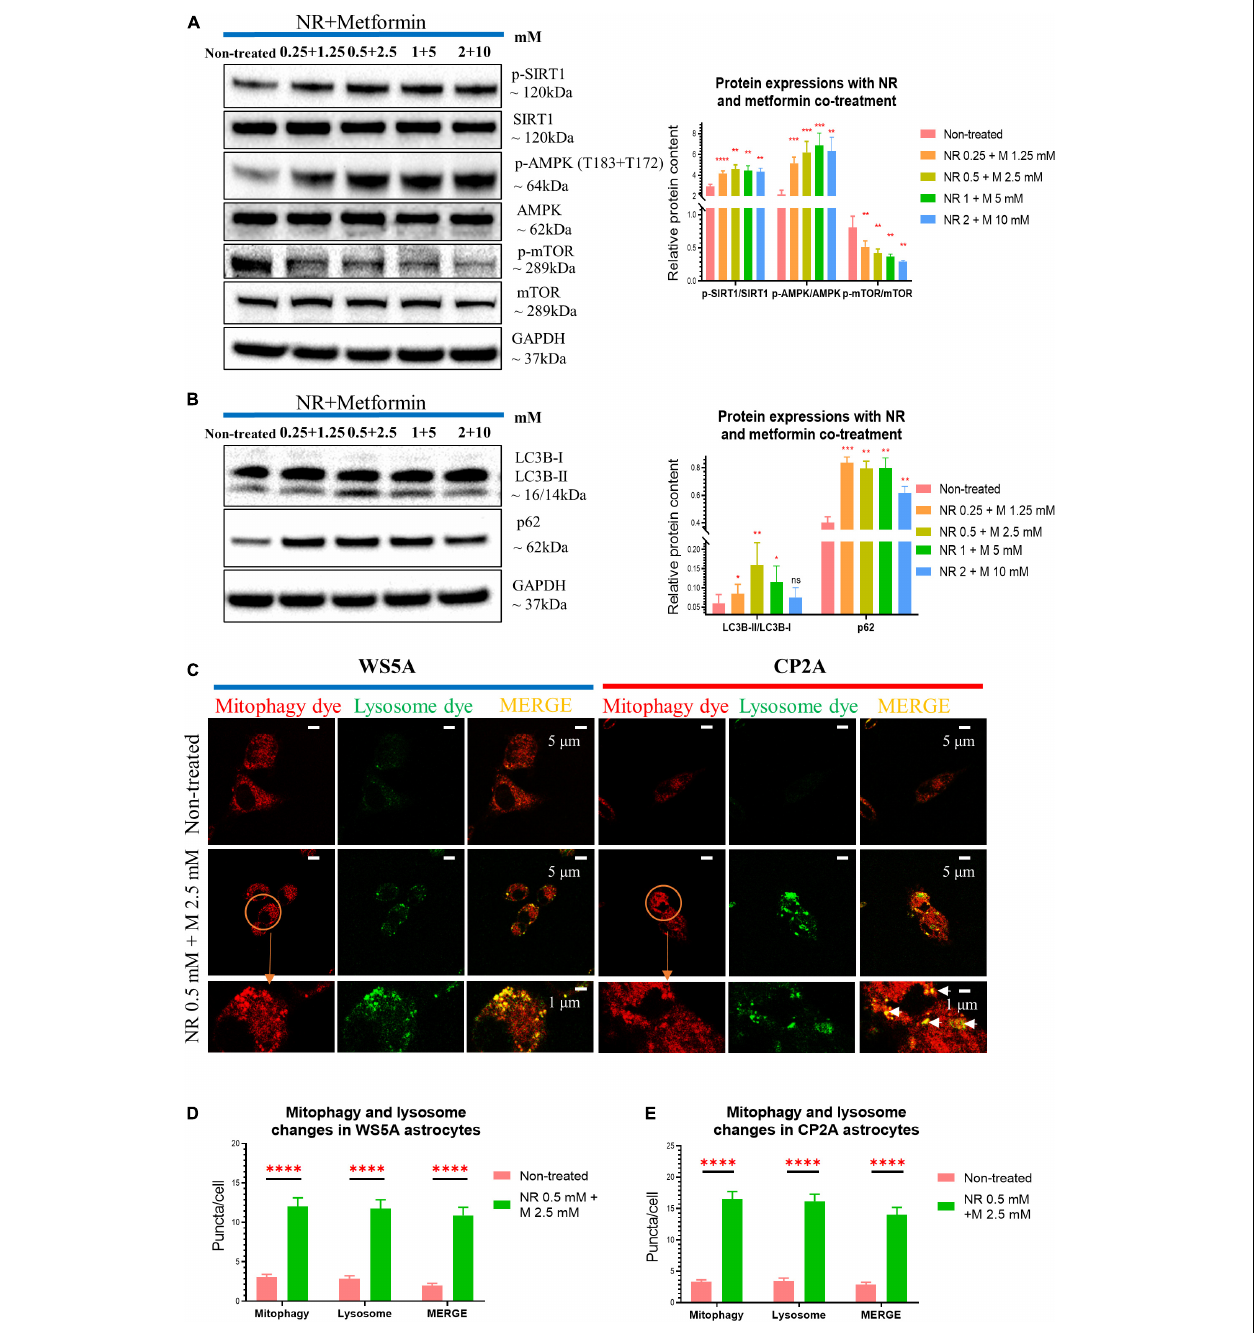
FIGURE 7 | Nicotinamide riboside and metformin co-treatment rescue mitophagy defect in POLG-mutant astrocytes. (A) Representative images and quantification of western blotting for p-SIRT1, SIRT1, p-AMPK (T183 + T172), AMPK, p-mTOR, mTOR, GAPDH, and in the POLG WS5A astrocytes treated with a serial concentration of NR and metformin co-treatment for 72 h. (B) Representative images and quantification of the western blotting for LC3B-I, LC3B-II, p62, and GAPDH in the POLG WS5A astrocytes treated with a serial concentration of NR and metformin co-treatment for 72 h. (C) Representative confocal images of immunostaining for mitophagy dye (red), lysosome dye (green), and MERGE (yellow) in WS5A and CP2A astrocytes with and without NR and metformin dual treatment. Scale bar is 5 or 1 µ m. White arrows denote mitophagy formation. (D,E) Quantification of the puncta numbers/cell of mitophagy dye, lysosome dye, and MERGE in WS5A (D) and CP2A astrocytes (E) with and without NR and metformin co-treatment. Data information: the data in A,B represent one clone from WS5A. The data in C represent one clone from WS5A with and without co-treatment, one clone from CP2A with and without co-treatment. The data in D,E , 40,000 astrocytes per sample were seeded and two clones from WS5A with and without co-treatment and two clones from CP2A with and without co-treatment were observed with three technical replicates. Mann–Whitney U test was used for the data presented in A,B,D,E . Significance is calculated by comparison to non-treated cells and is denoted for p -values of less than 0.05. * p < 0.05; ** p < 0.01; *** p < 0.001; **** p < 0.0001; ns, not significant.